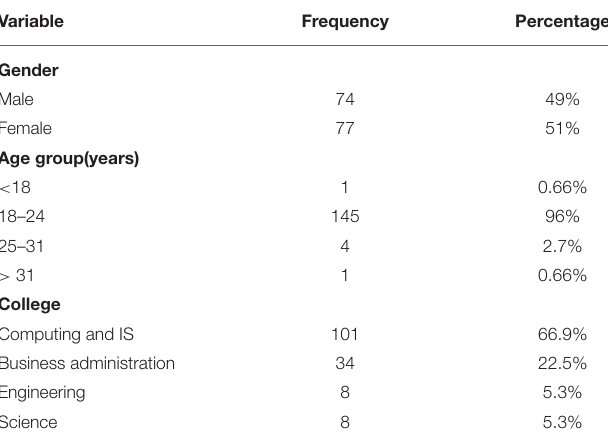
TABLE 1 | Demographic characteristics of the respondents.